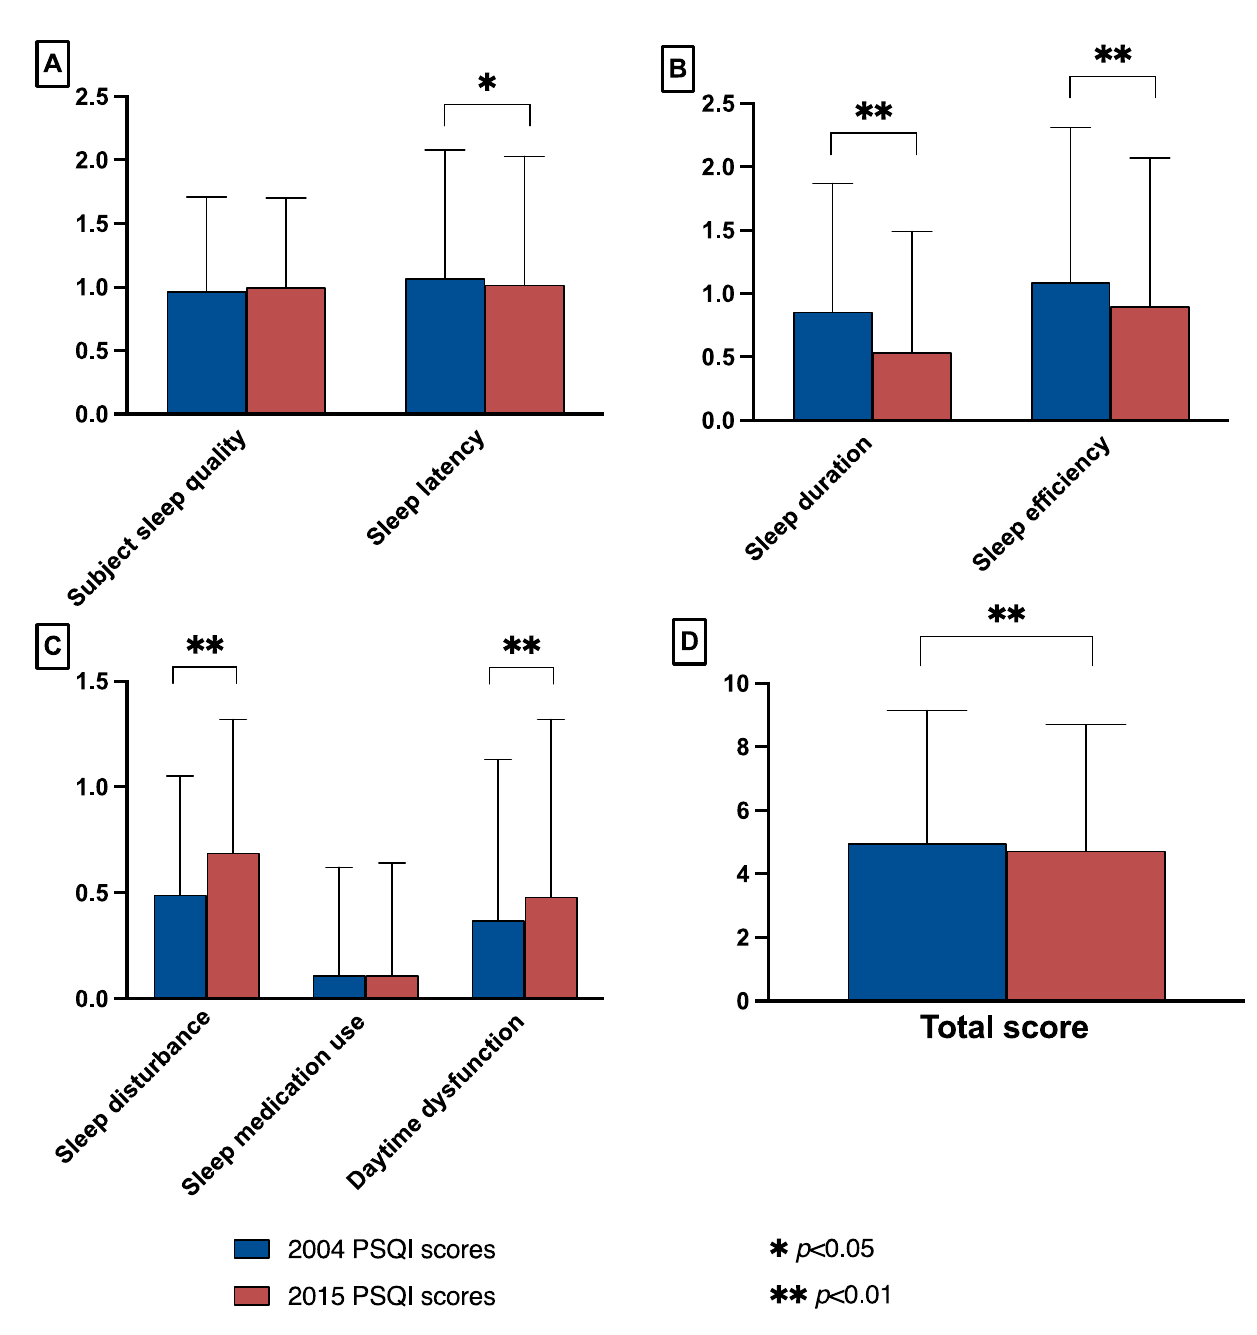
Figure 1. Comparison of PSQI scores for each factor between 2004 and 2015 for people aged ≥ 60 years in Shandong province. ( A ) The factors compared were: subjective sleep quality (effect sizes = − 0.04), sleep latency (effect sizes = 0.05). ( B ) The factors compared were: sleep duration (effect sizes = 0.33), sleep efficiency (effect sizes = 0.16). ( C ) The factors compared were: sleep disturbance (effect sizes = − 0.33), sleep medication use (effect sizes = 0.00), and daytime dysfunction (effect sizes = − 0.13). ( D ) Comparison of total scores (effect sizes = − 0.06).